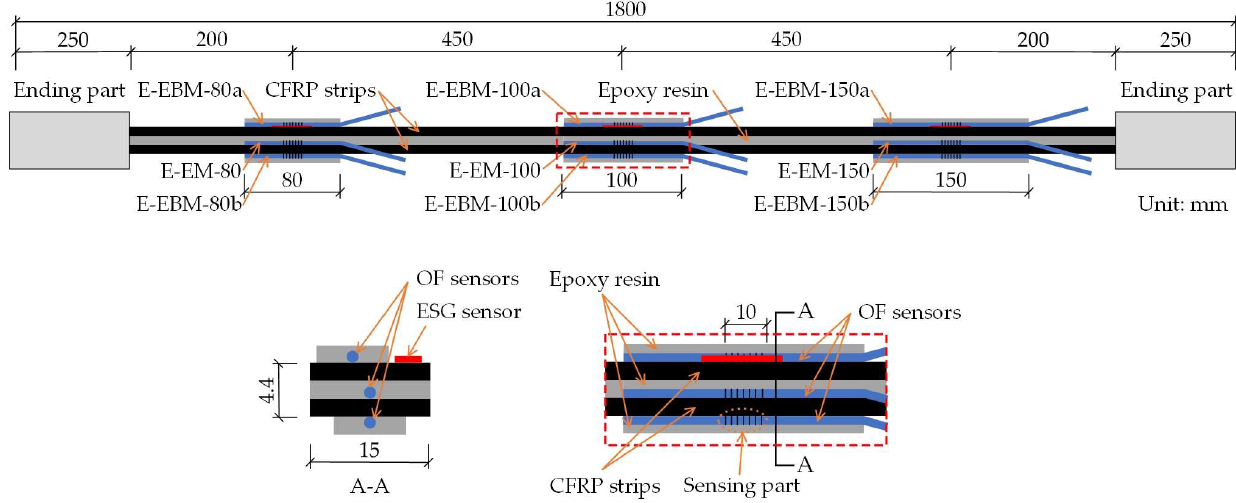
Figure 5. Geometrical details of the E specimen.